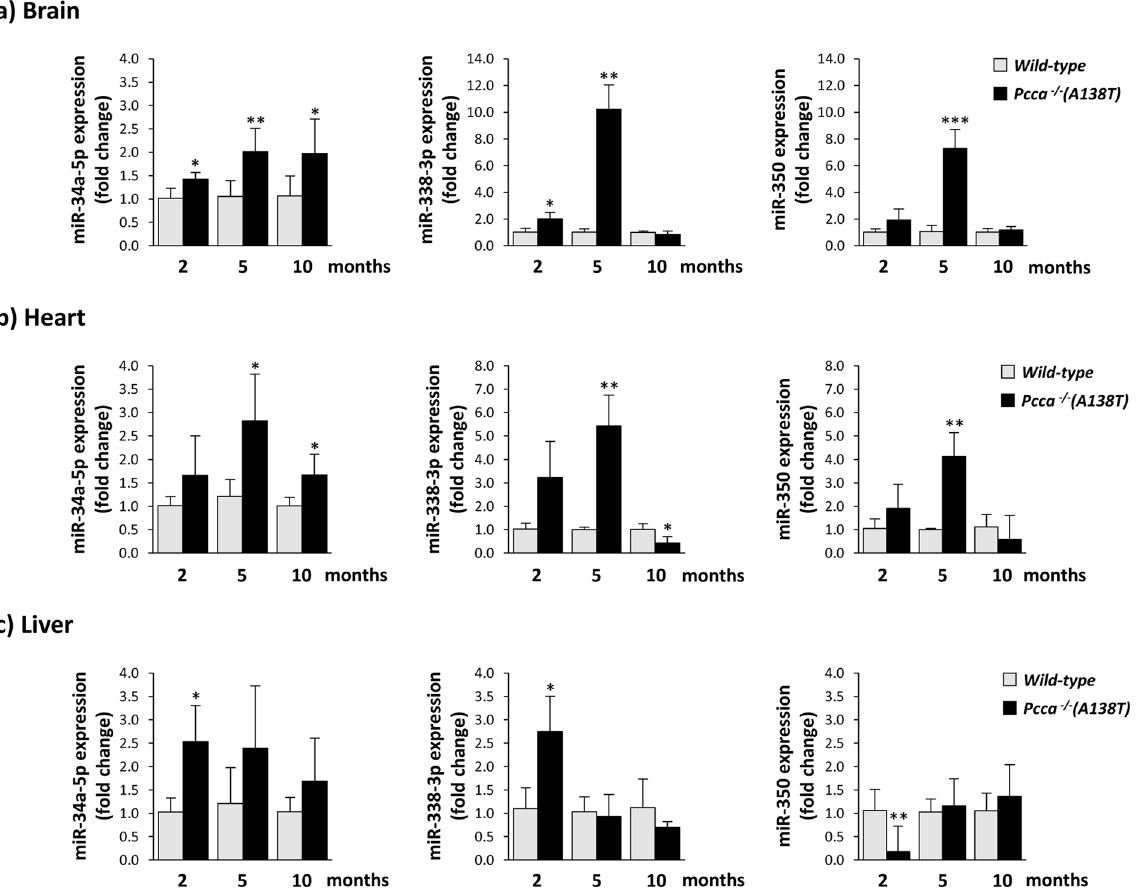
Figure 2. Relative expression levels of miR-34a-5p, miR-338-3p and miR-350 in brain ( a ), heart ( b ) and liver ( c ) tissues from PA mice at different ages. miRNA analysis was performed for wt and PA mouse samples (n = 4-5 per group) by qRT-PCR analysis. * p < 0.05, ** p < 0.01, *** p < 0.001